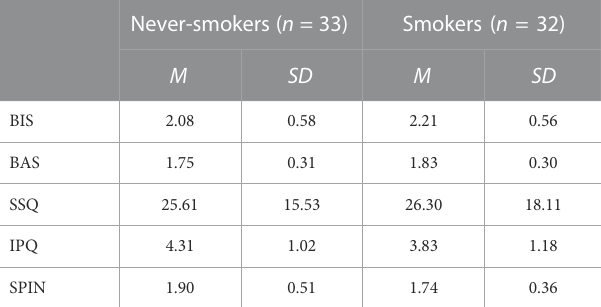
TABLE 1 Means (SD) of the scores of never-smokers and smokers on the Behavioral Inhibition System/Behavioral Approach System scales (BIS/BAS scales), the Simulator Sickness Questionnaire (SSQ), the iGroup Presence Questionnaire (IPQ), and the Social Phobia Inventory (SPIN). Never-smokers ( n =